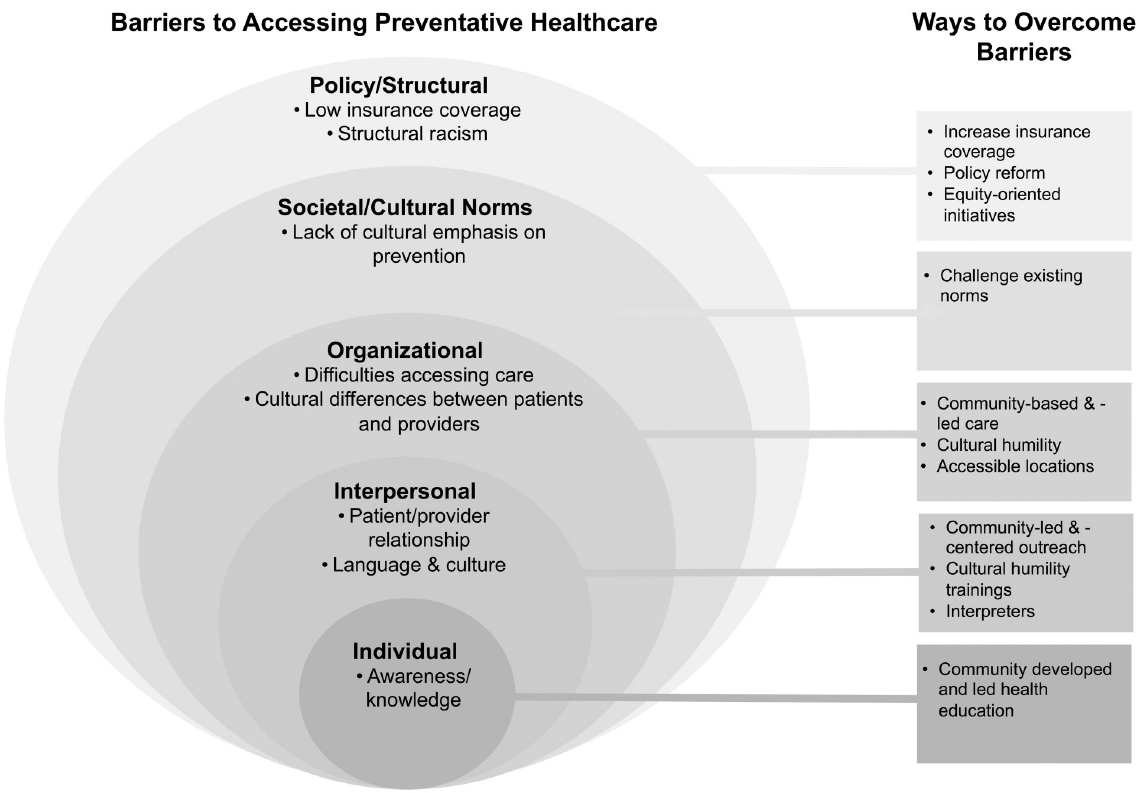
Fig 1. Socio-ecological model of barriers and potential solutions to accessing preventive health care among African-born individuals in King County.